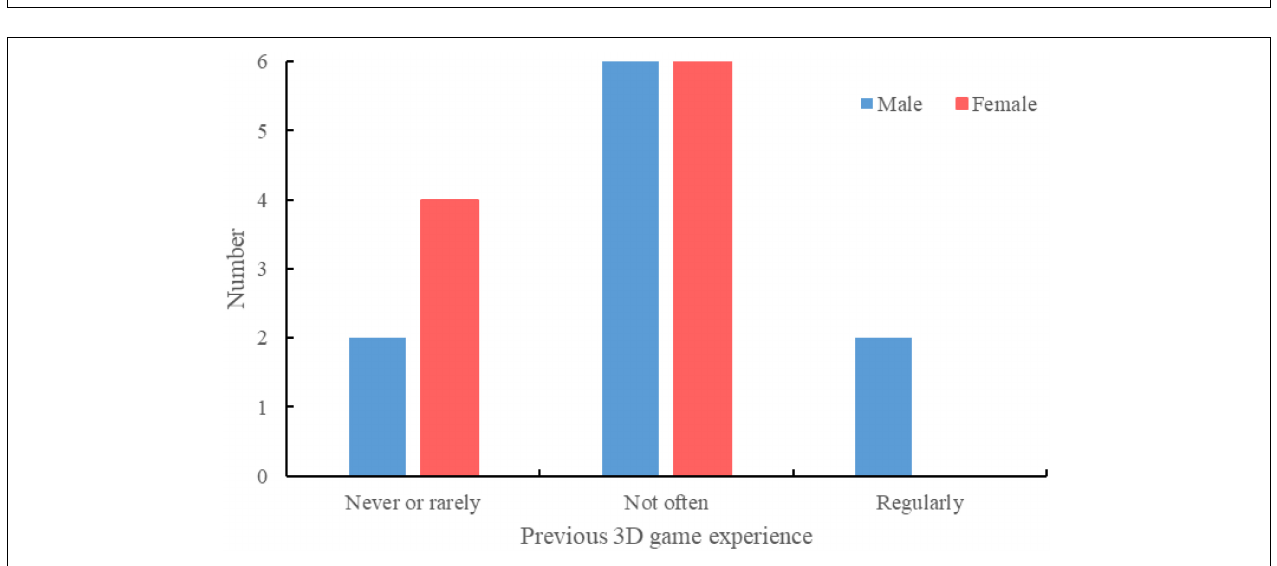
FIGURE 5 | UML class diagram of the software platform.